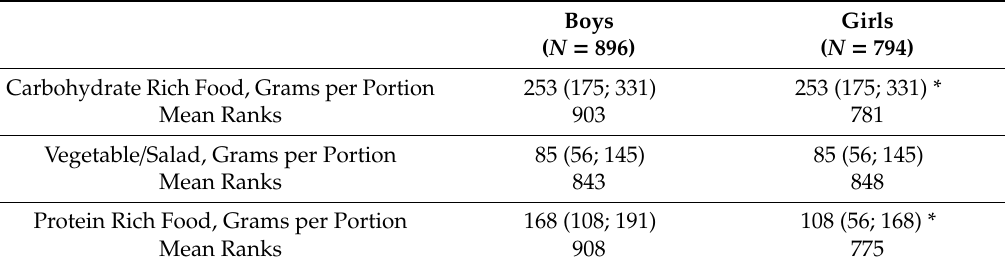
Table 4. Meal portion size by